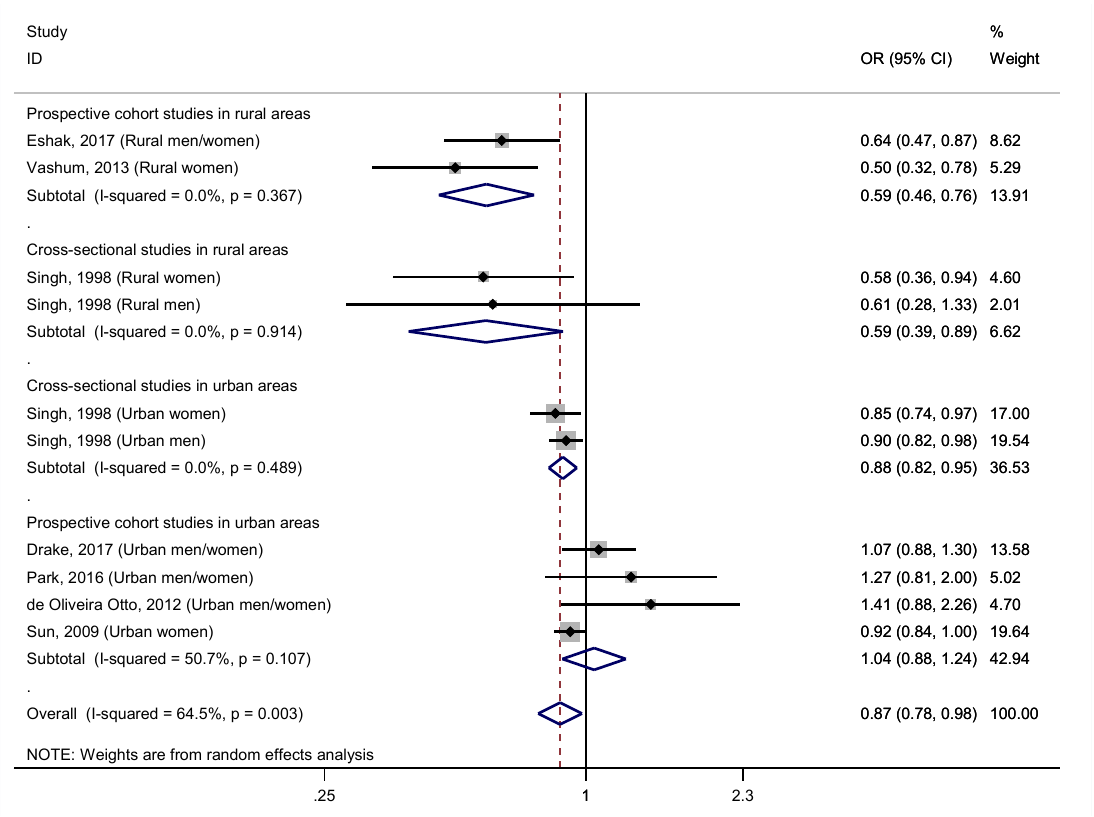
Figure 4. Forest plot of pooled effect size of the highest vs. lowest dietary zinc intake for T2DM according to study design and area of residence (prospective cohort studies in rural areas, cross-sectional studies in rural areas, cross-sectional studies in urban areas, and prospective cohort studies in urban areas). Squares represent ORs for each study, and the size of the square is the study-specific statistical weight. Horizontal lines indicate the 95% CI of each study. Diamond represents the combined OR estimate with corresponding 95% CI.